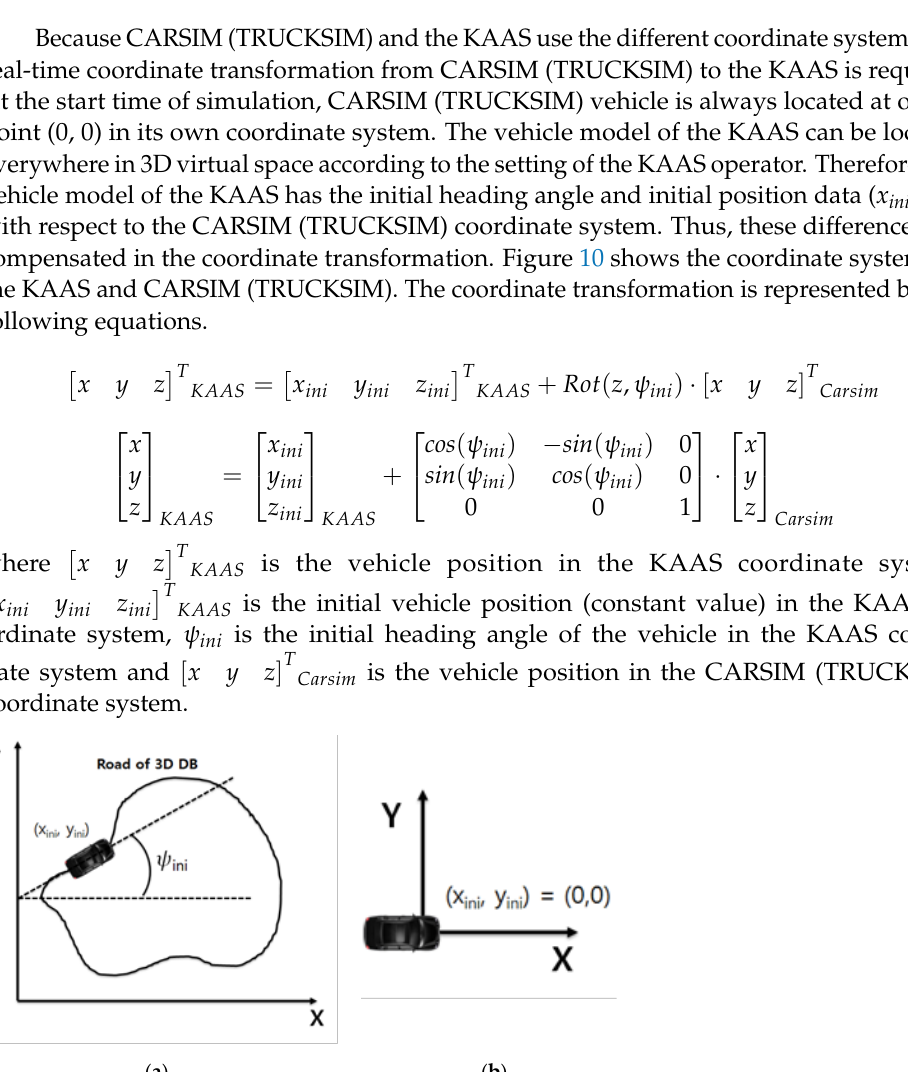
Figure 9. Data communication between the KAAS and CARSIM (TRUCKSIM).